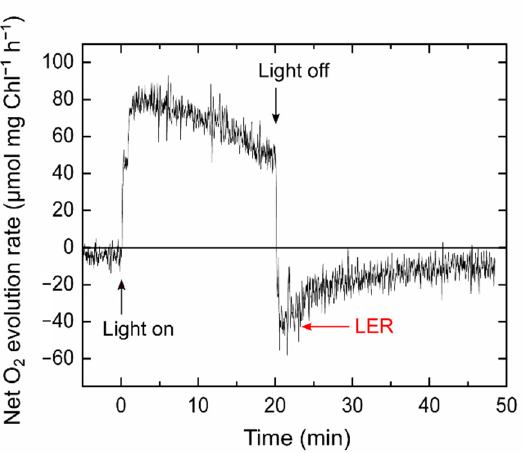
Figure 2. Light-enhanced respiration (LER) in Synechocystis sp. PCC 6803. The cyanobacterial cells adapted to darkness for 24 h (10 µg Chl mL − 1 ) were illuminated with a red actinic light (190 µmol photons m − 2 s − 1 ) for 20 min as indicated by black arrows. We defined the O 2 uptake rate just after the light was turned off as LER (red arrow). The representative data ( n = 9, biological replicates) are shown.